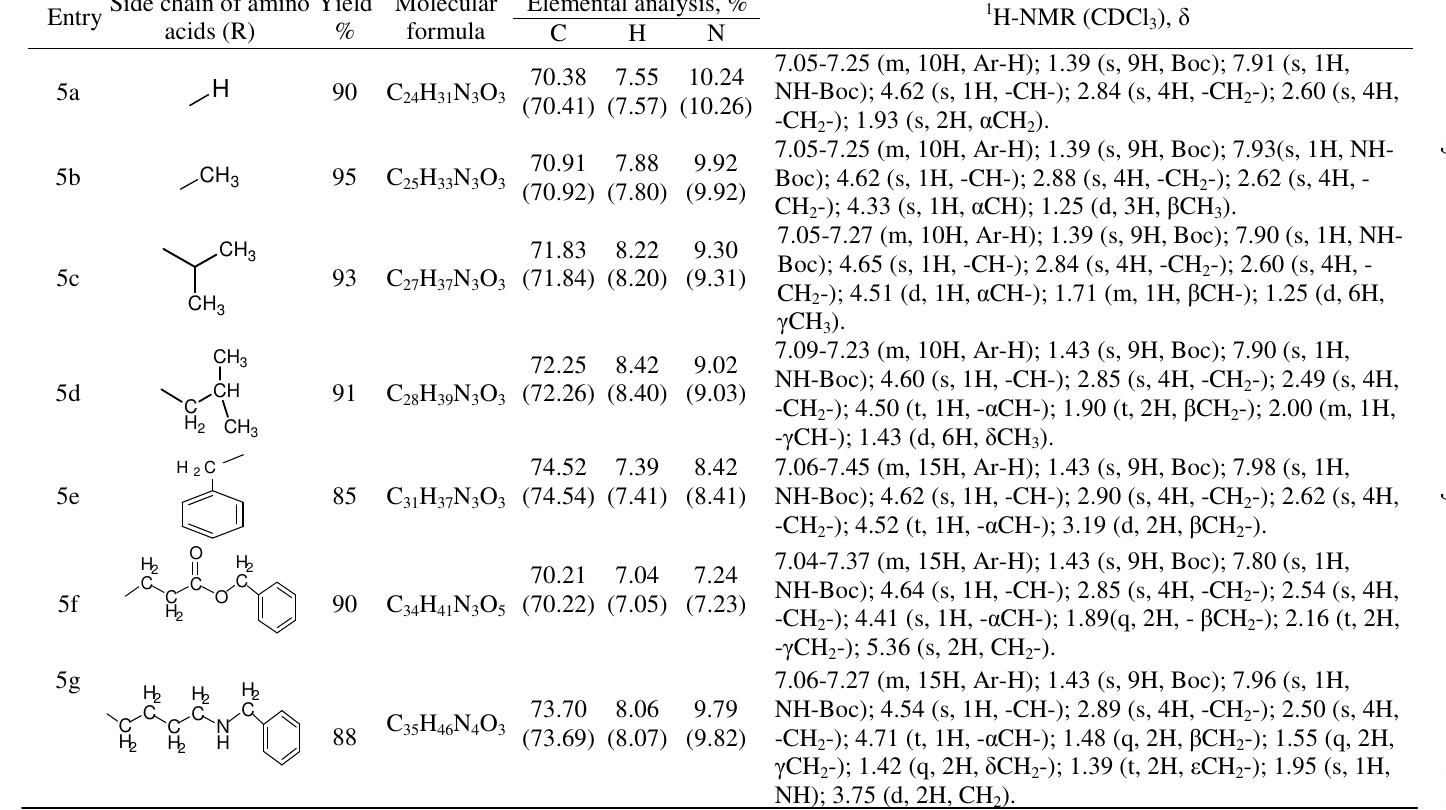
Table 1. Analytical data of the synthesized